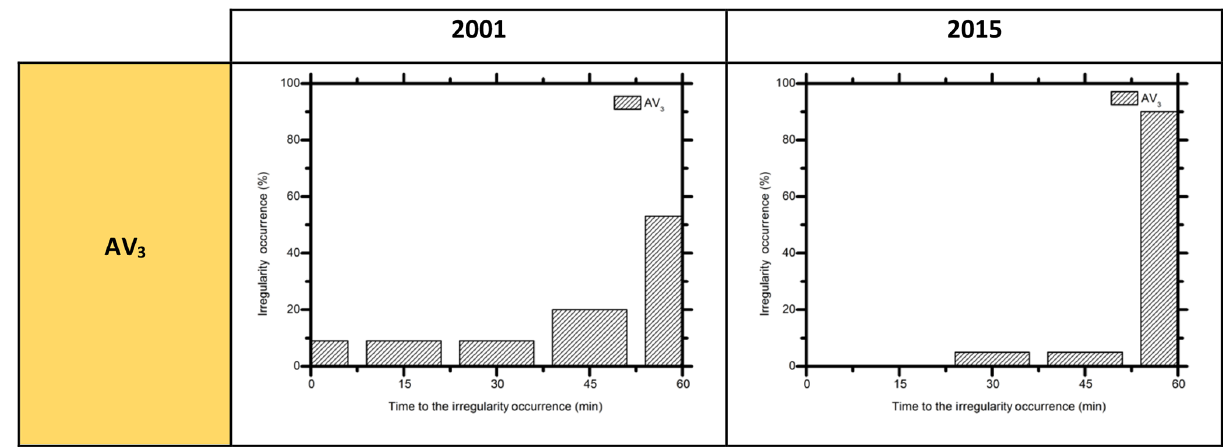
Figure 5. The time relationship between the V zp parameter, considering the AV 3 index, and the irregularity observations in ionograms in the winter of 2001 and 2015 over São Luís. The V zp did not reach the AV 4 and AV 5